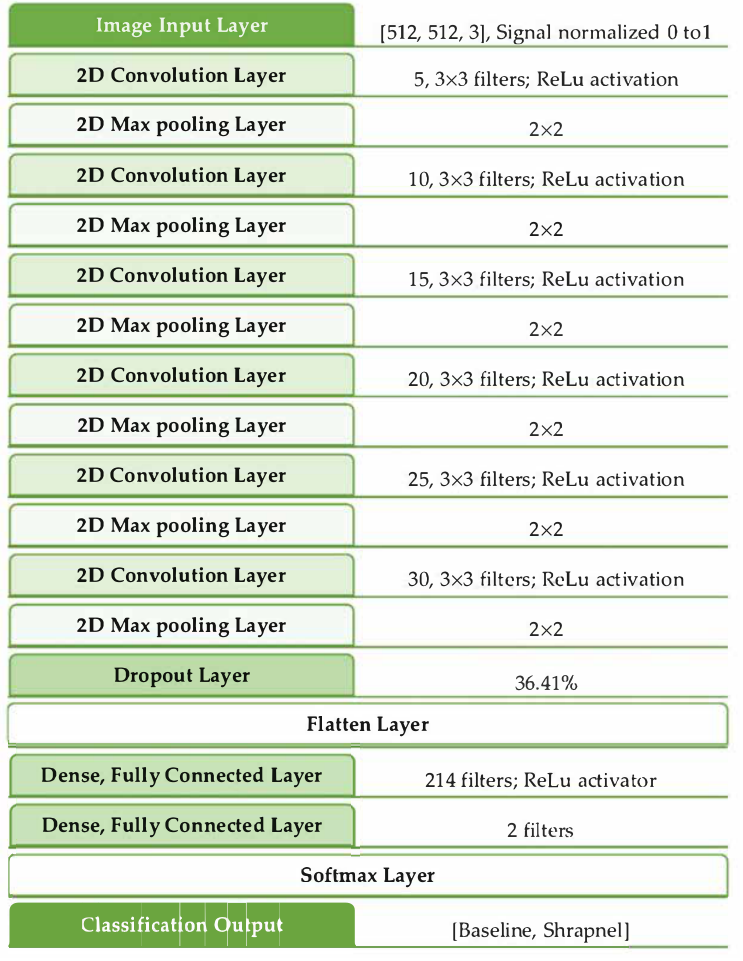
Figure 2. Network architecture for the optimized ShrapML model.